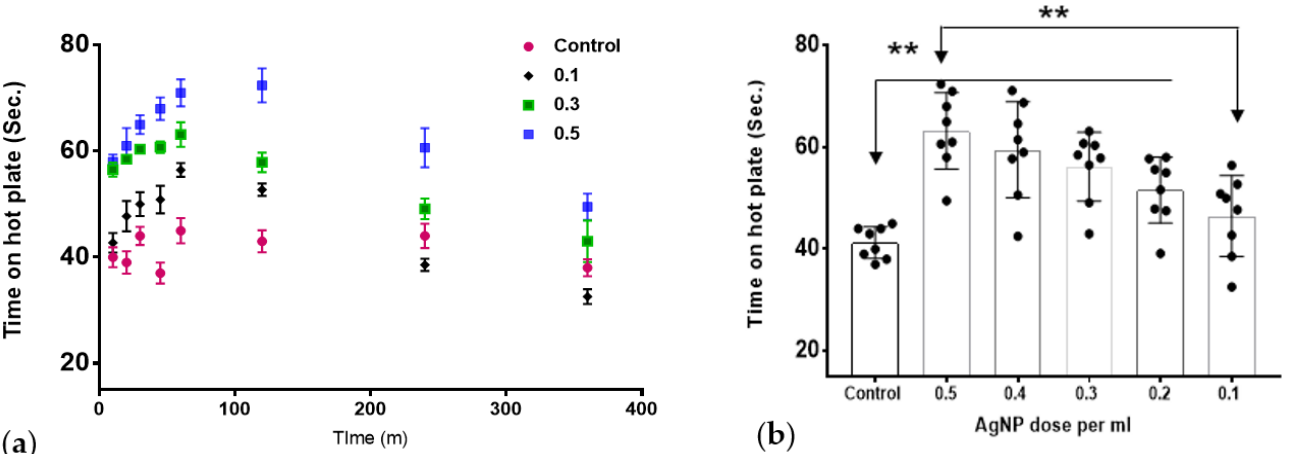
Figure 2. The effect of AgNPs on thermal withdrawal latency. ( a ) The temporal response over the study duration. ( b ) The overall thermal withdrawal latency across all time points. AgNPs showed significant increase in thermal withdrawal latency in treated groups (0.2 – 0.5 mL AgNPs) that showed a significant difference compared to the control group; the difference between the lowest dose and highest dose was also statistically significant (** p < 0.01) ” n ” = 8.